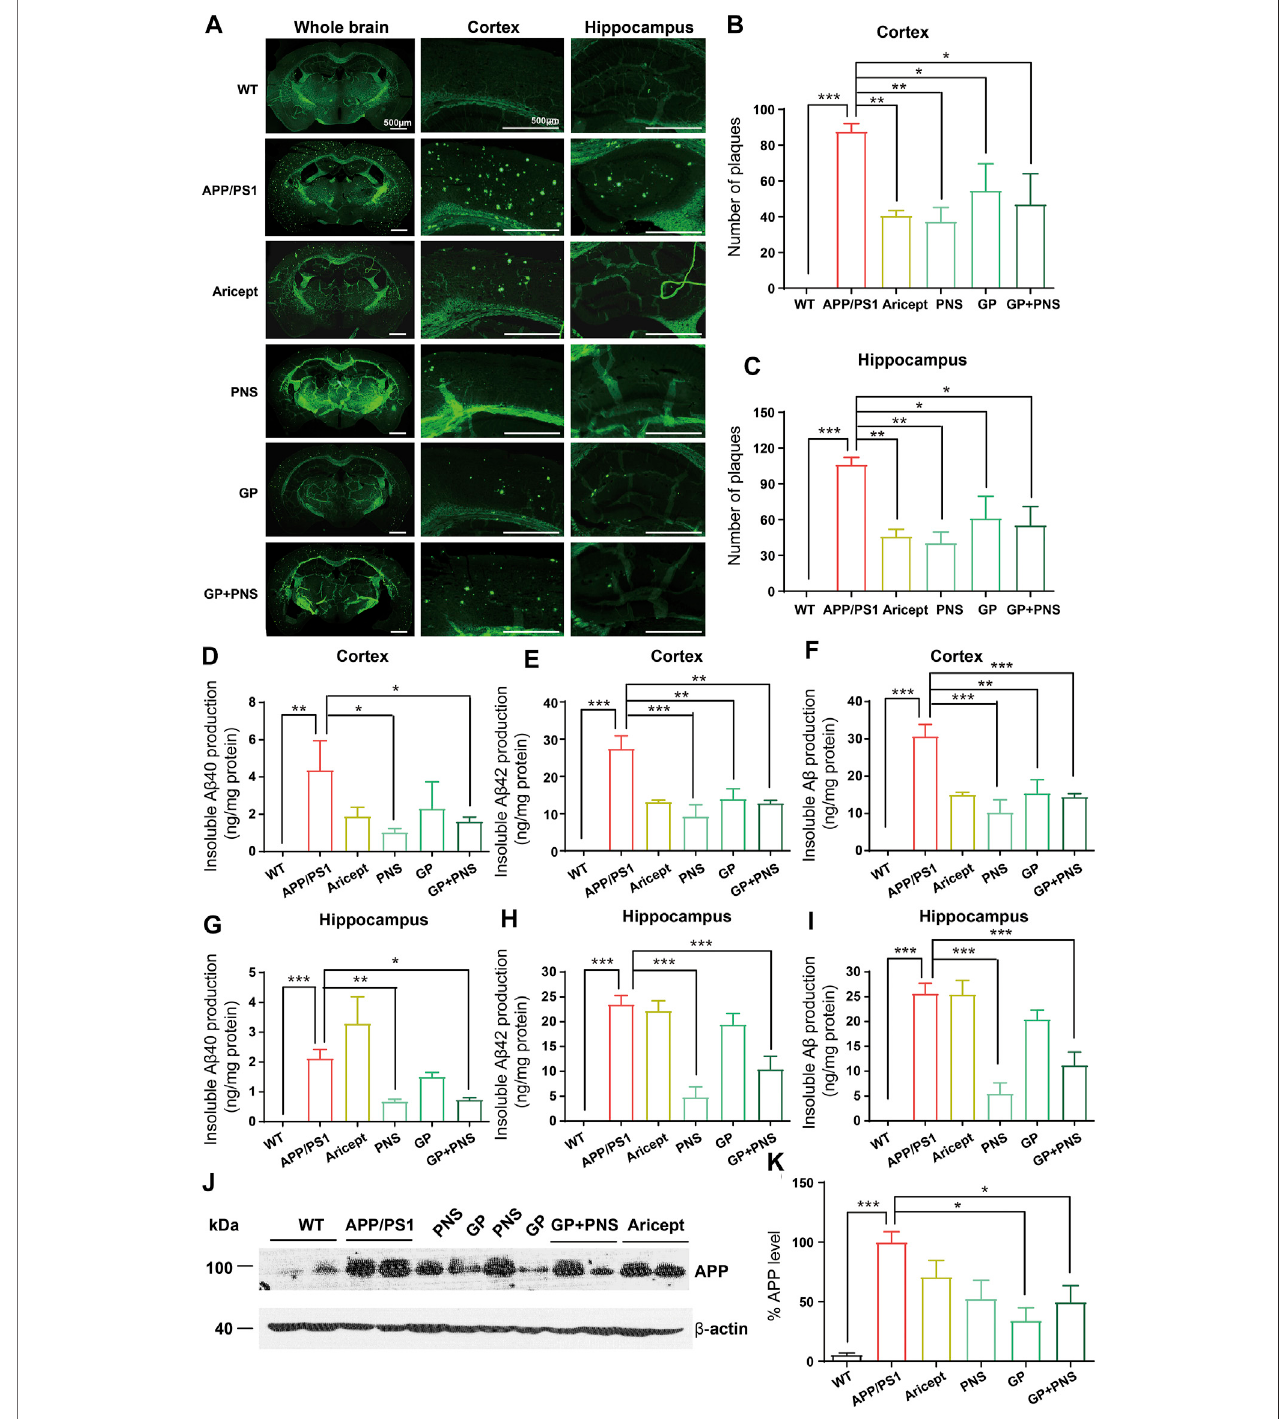
FIGURE 2 | Reduction of A β production and amyloid deposits. (A) The typical feature of amyloid deposits in brains. (B) The number of amyloid plaques was analyzedinthecortex. (C) Thenumberofamyloidplaqueswasanalyzedinthehippocampus. (D-F) TheamountsofinsolubleA β 40 (D) ,insolubleA β 42 (E) andinsoluble A β intotal (F) wereanalyzed inthecortex. (G-I) Theamounts ofinsoluble A β 40 (F) ,insolubleA β 42 (G) and insolubleA β intotal (I) wereanalyzed inthehippocampus. (J- K) TheWesternblotofAPP (J) andanalysis (K) .(n=5,Dataaremeans±SEM.ComparedwithAPP/PS1,* p < 0.05,** p < 0.01,and*** p < 0.001;one-wayANOVA, followed by Tukey ’ s multiple comparison